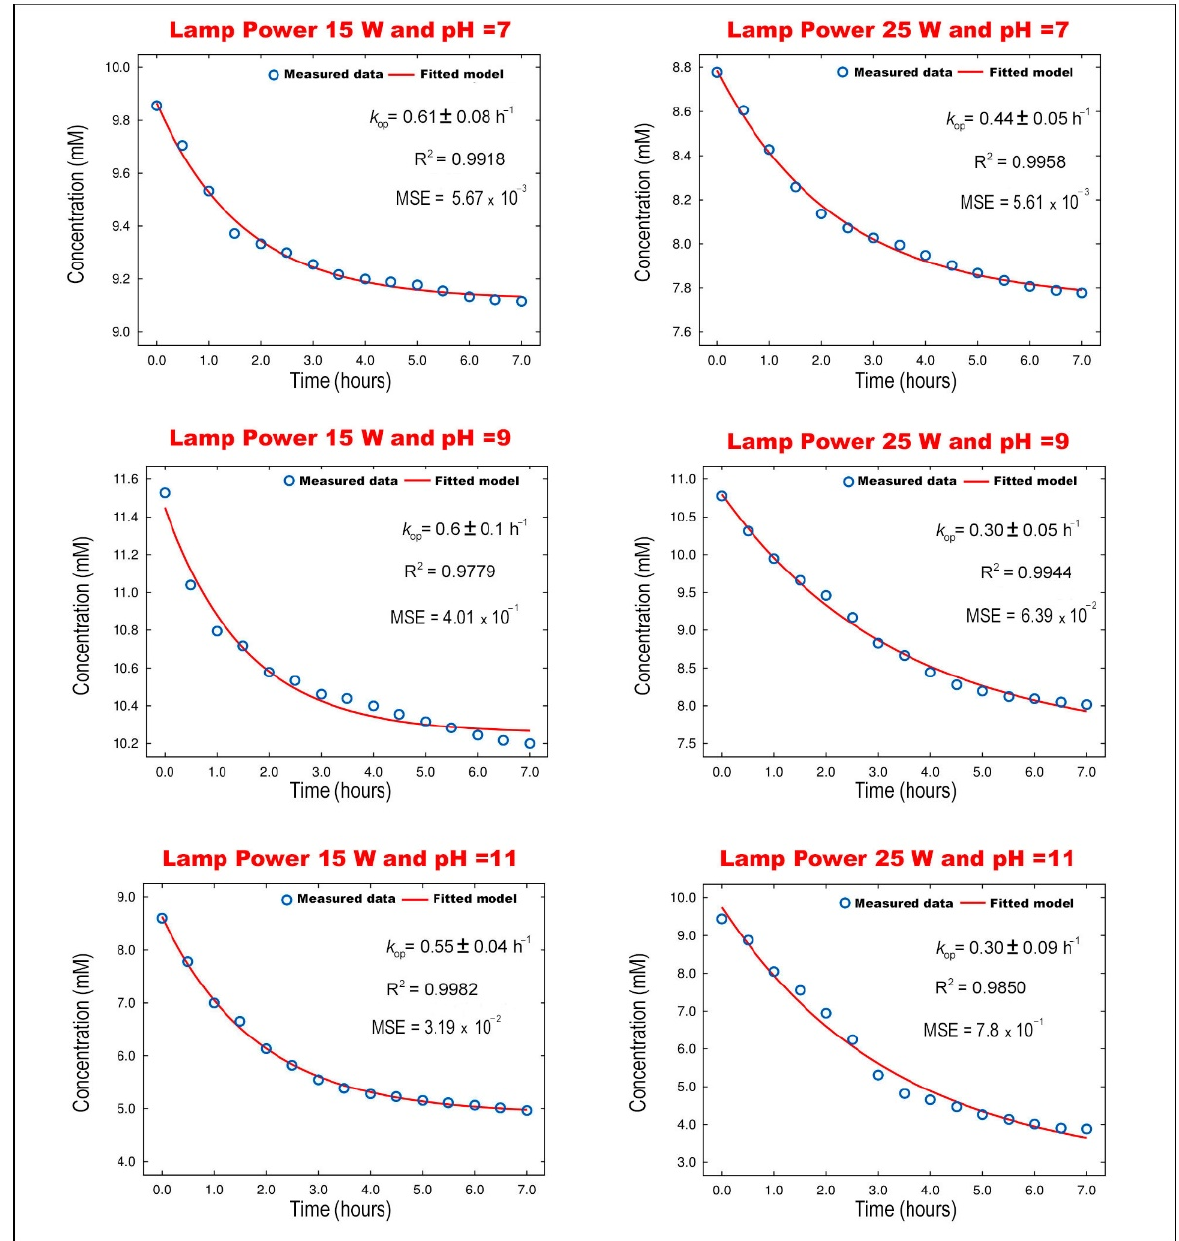
Figure 6. Fit of the kinetics of NH 4+ /NH 3 degradation by photocatalysis to a monoexponential progress kinetic curve to baseline .